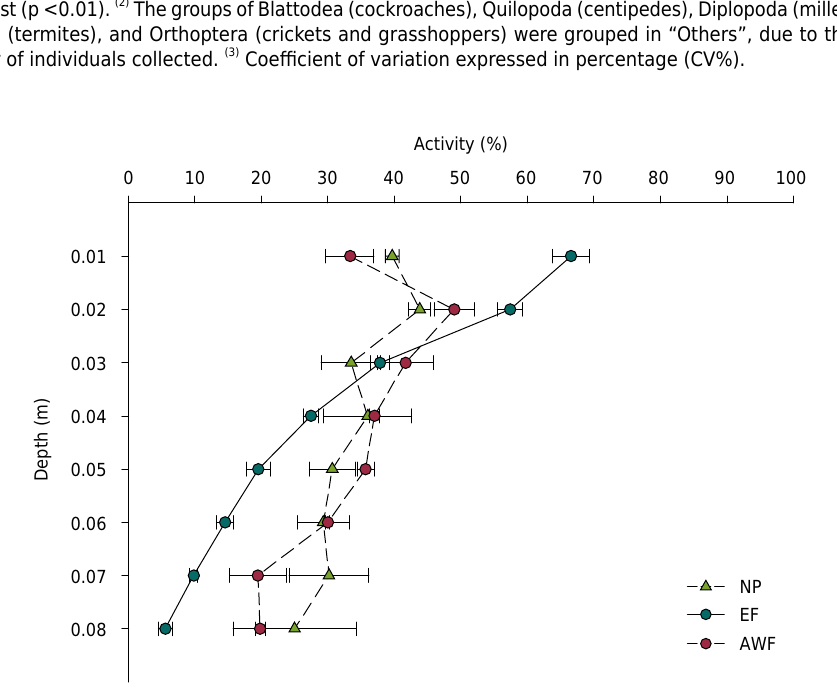
Figure 3. Feeding activity of organisms in the soil at different depths under natural pasture (NP), in the eucalyptus forest (EF), and in the eucalyptus forest after wildfire (AWF), in São Gabriel, RS, Brazil. The dots represent the mean values and the horizontal bars correspond to the standard